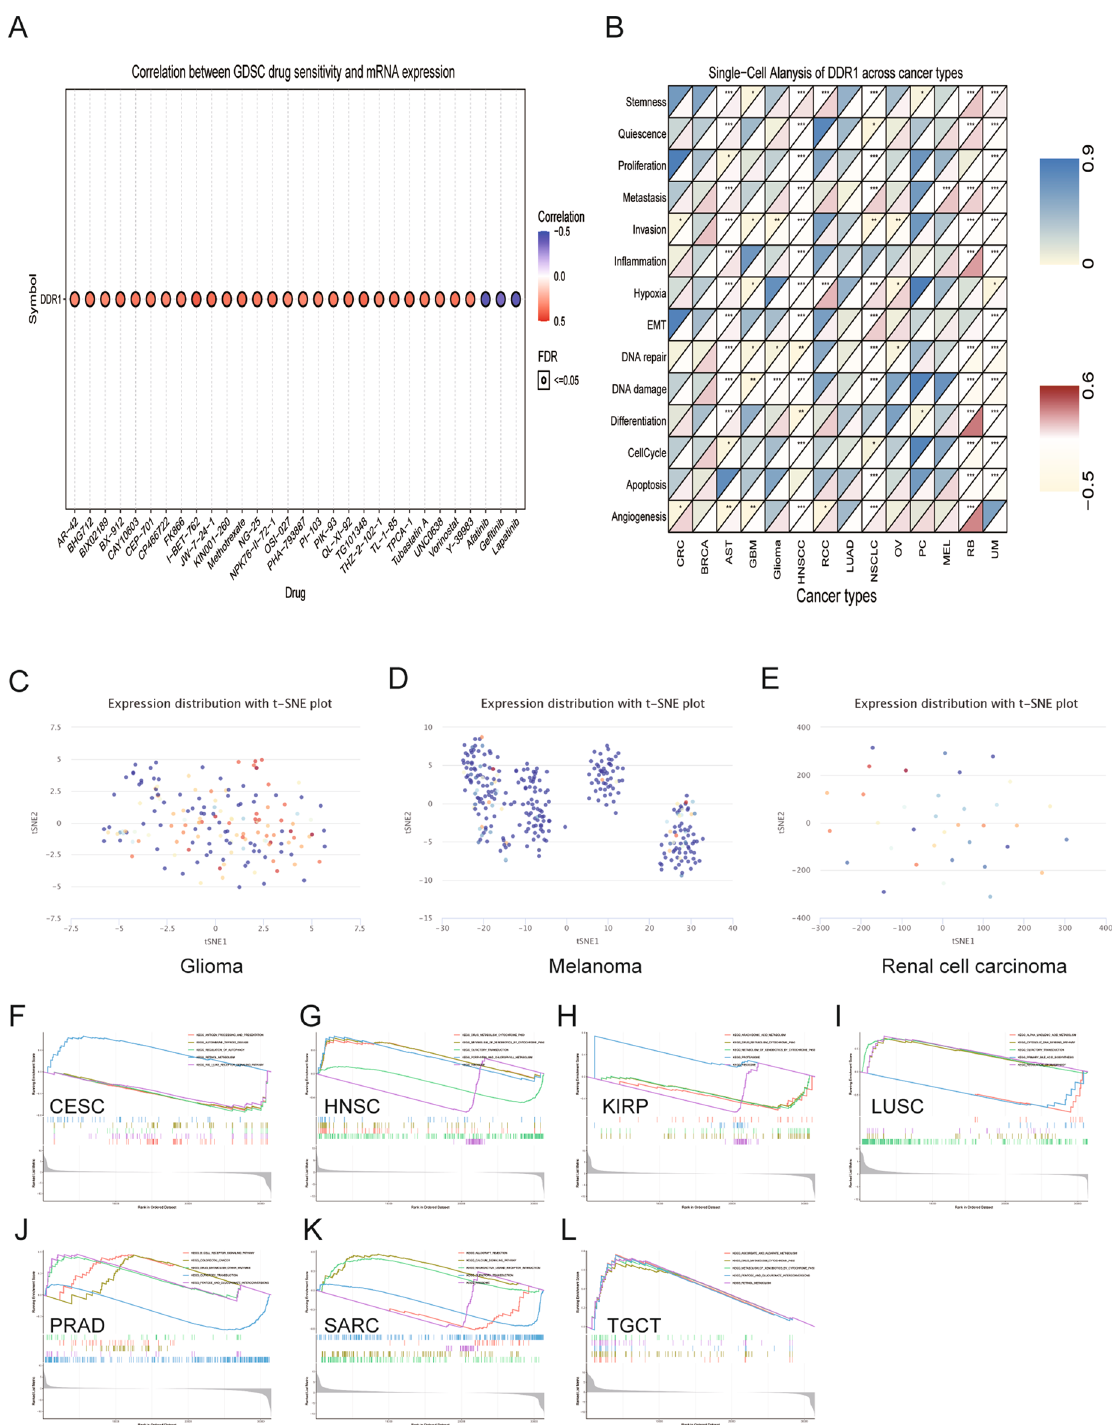
Figure 10. The relationship between DDR1 mRNA expression and drug sensitivity and tumor functional status and the results of GSEA analysis. ( A ) Heatmap illustrating the correlation between DDR1 expression and different tumor functional statuses based on the CancerSEA database. * P < 0.05, ** P < 0.01, *** P < 0.001. ( B ) Figure summarizes the correlation between DDR1 expression and the top 30 sensitivity drugs across cancers based on the GDSC database. ( C–E ) T-SNE diagram demonstrates DDR1 expression profiles in single cells of glioma, melanoma, and renal cell carcinoma samples. ( F–L ) KEGG pathway analysis of DDR1 in multiple cancers. Curves of different colors show different functions or pathways regulated in different cancers. Peaks on the upward curve indicate positive regulation and peaks on the downward curve indicate negative